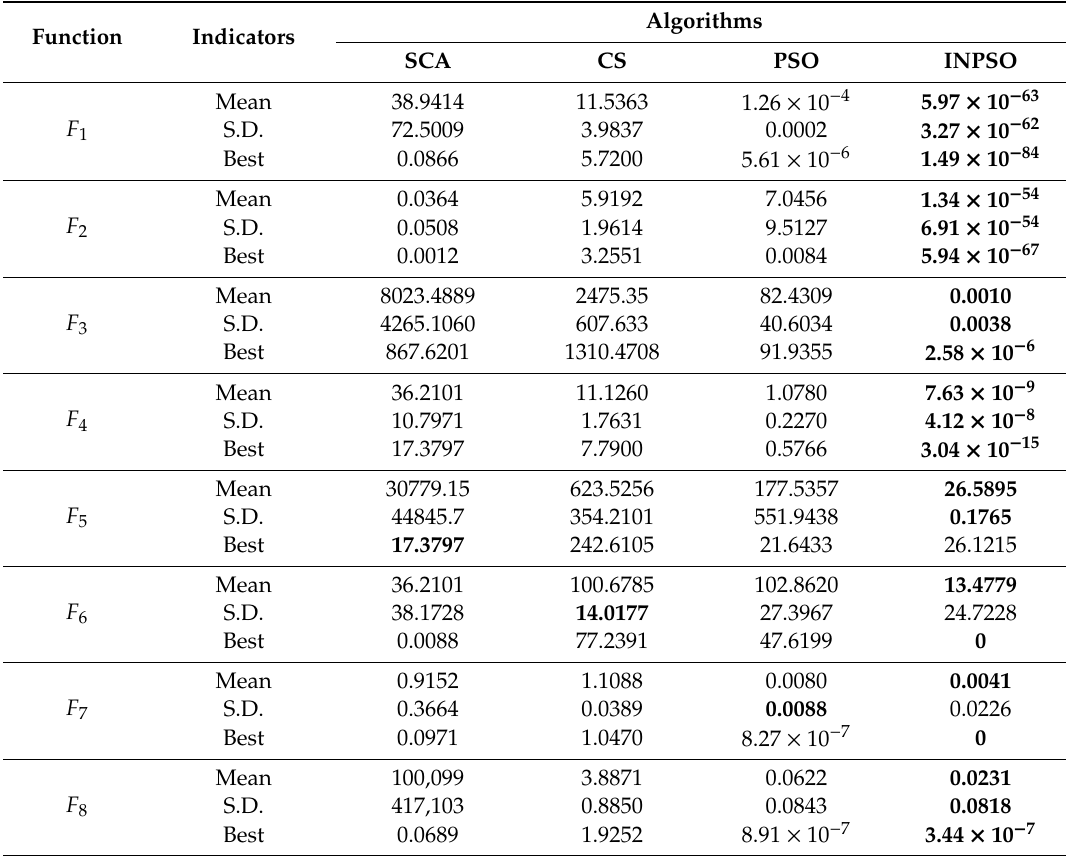
Table 3. Optimization results on unimodal and multimodal